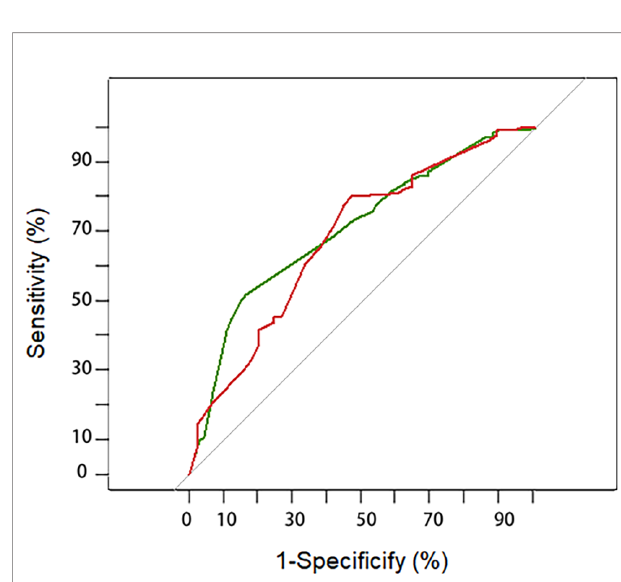
FIGURE 2 | Receiver – operating characteristic curve for the prediction model in the development (green line) and validation cohort (red line). The AUC (area under the curve) indicated the discriminative power of the nomogram. The modeling group has a value of 0.71 (95%CI: 0.64-0.78) and the validation group has a value of 0.68 (95%CI: